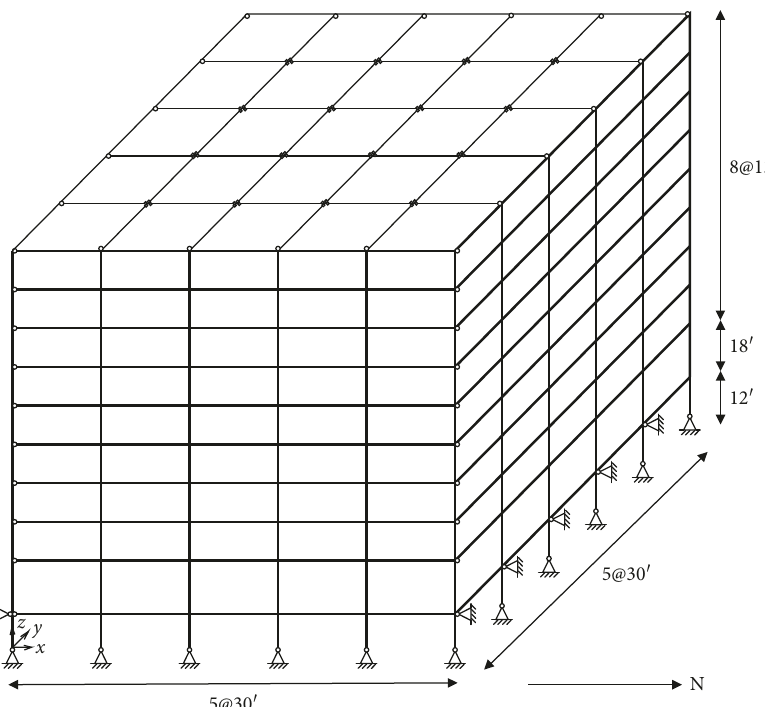
Figure 2: Isometric view of the 10-level